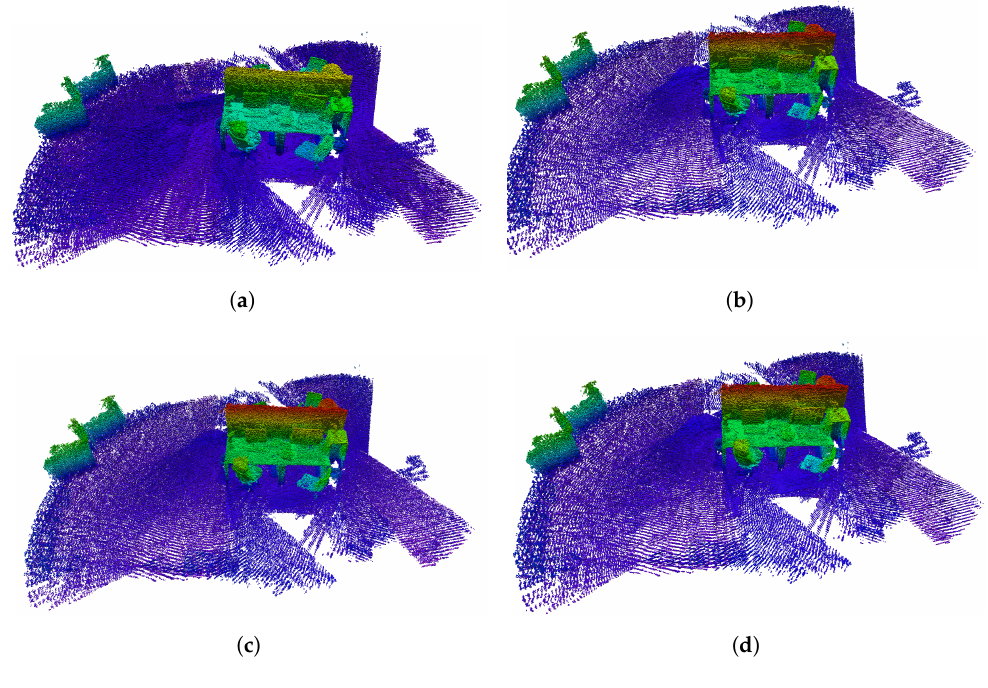
Figure 12. Benchmark outputs at 0.01 m grid resolution. ( a ) OctoMap. ( b ) Nanomap No Filter. ( c ) Nanomap Filter Modes 0 and 1. ( d ) Nanomap Filter Modes 2 and